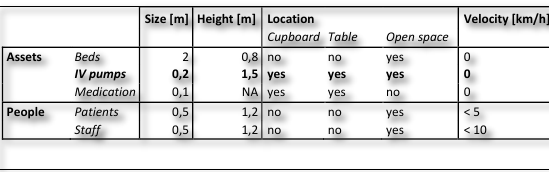
Table 1: Input from requirements of the hospital use case for definition of the test cases